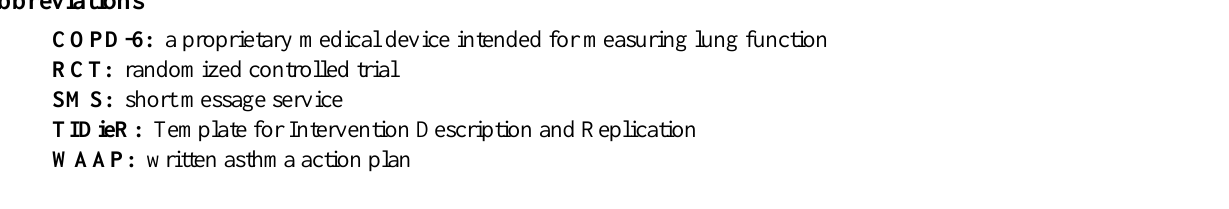
COPD-6: a proprietary medical device intended for measuring lung function RCT: randomized controlled trial SMS: short message service TIDieR: Template for Intervention Description and Replication WAAP: written asthma action